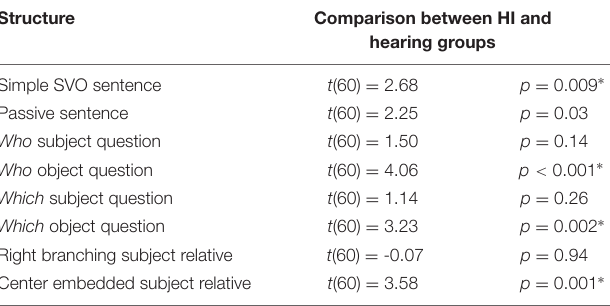
TABLE 5 | Comparison of sentence repetition without structural errors in the HI and hearing groups per sentence type.